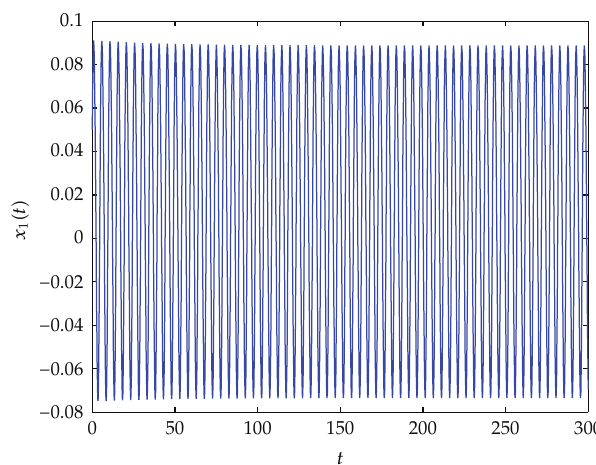
Figure 4: Trajectories graphs of thesystem (cid:2) 4.1 (cid:3) with τ 1 (cid:6) 0 . 01 ,τ 2 (cid:6) 0 . 04, and τ 1 (cid:7) τ 2 (cid:6) 0 . 05 > τ 0 ≈ 0 . 01. Hopf bifurcation occurs from the equilibrium E ∗ (cid:2) 0 , 0 (cid:3) . The initial value is (cid:2) 0.05, 0.01 (cid:3) .